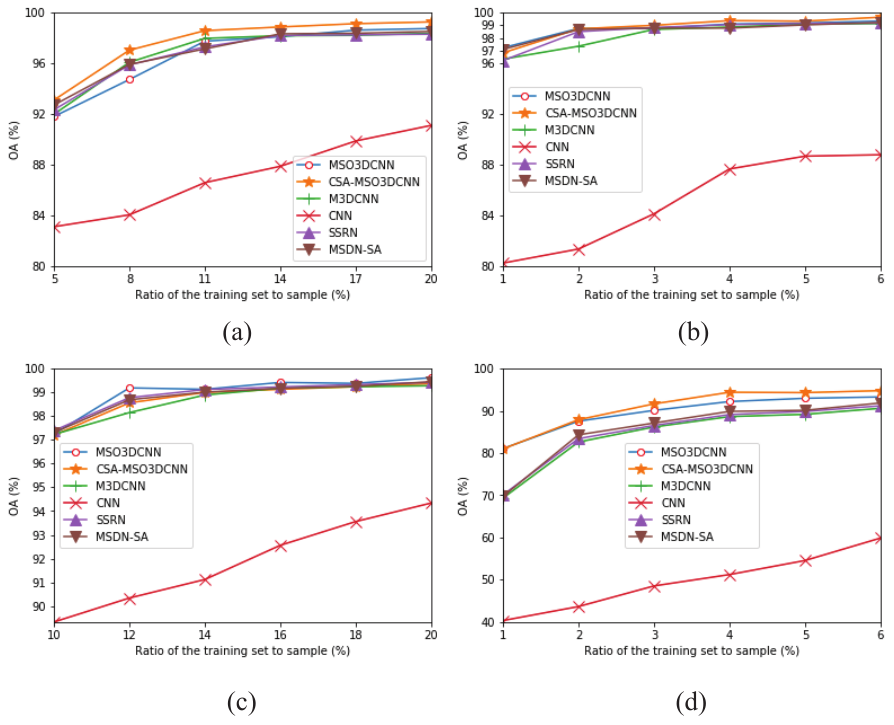
Figure 16. The OA of different training set sizes for four data sets. ( a ) Indian Pines data set. ( b ) University of Pavia data set. ( c ) Grss_dfc_2013 data set. ( d ) Grss_dfc_2014 data